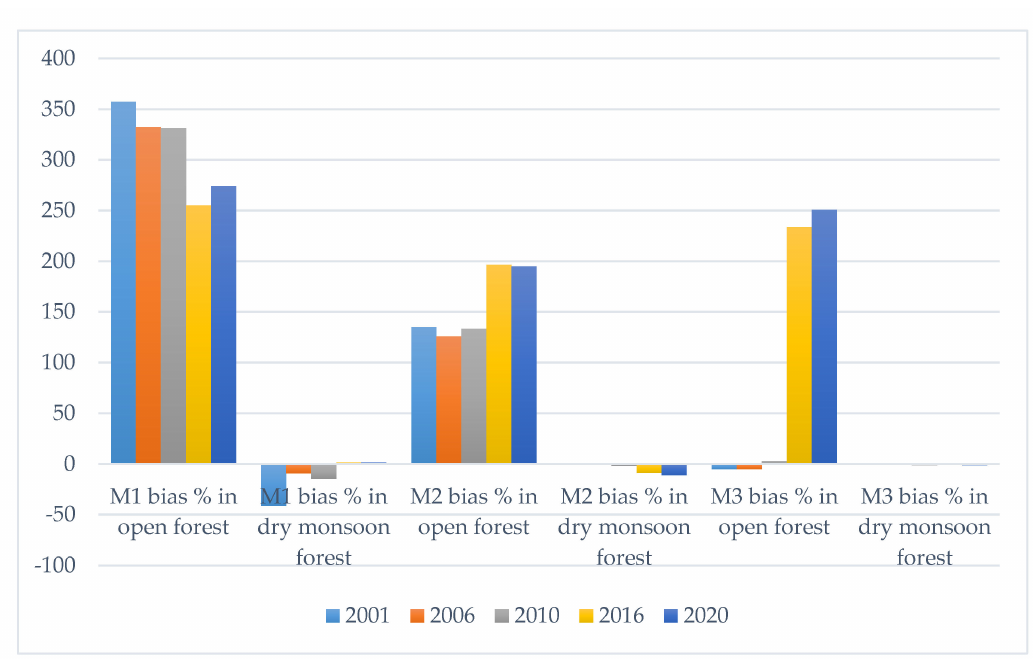
Figure 7. Range of bias percentage in the M1, M2, and M3 models for open and dry monsoon forest covers from 2001 to 2020, compared with best-fit model for forest